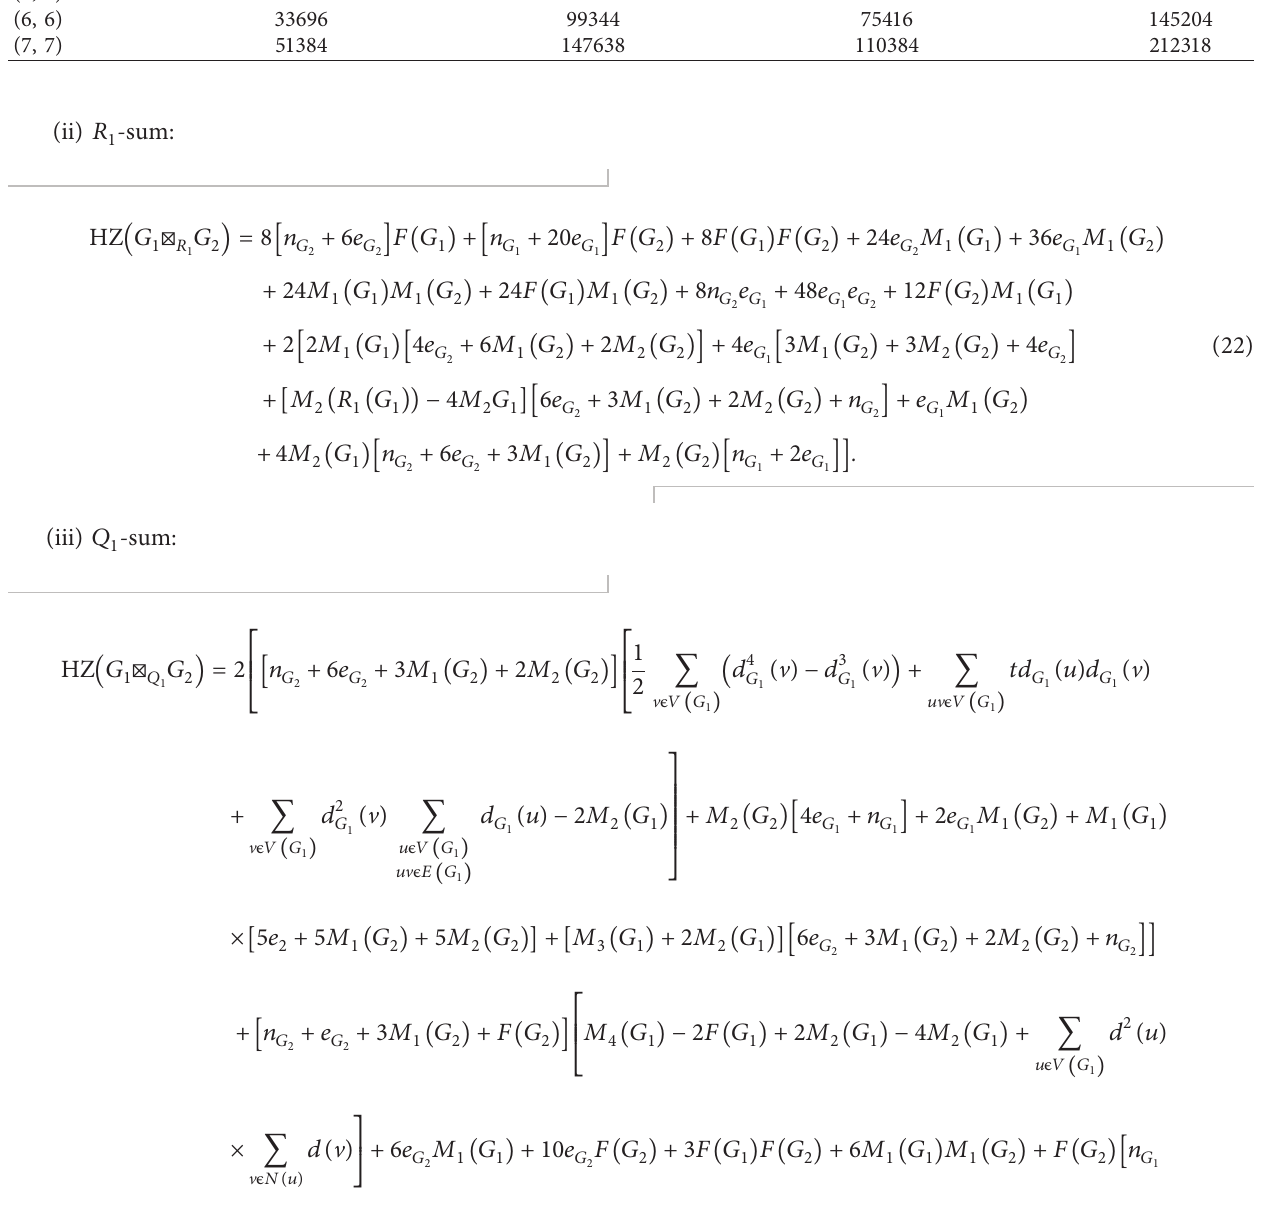
Table 1: Hyper-Zagreb index of F